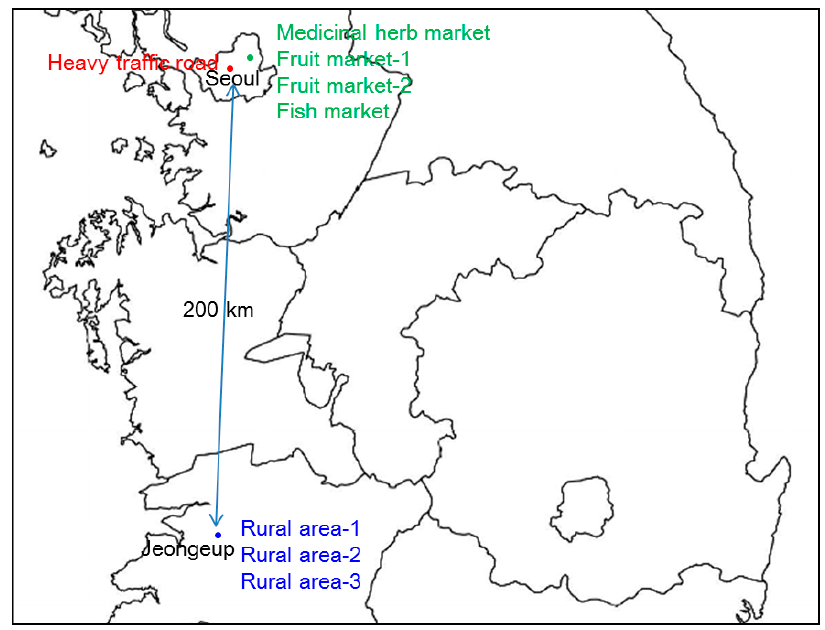
Figure 1. Sampling locations: a medicinal herb market, a fish market, two fruit markets, and a heavy traffic area in Seoul, and rural areas in Jeongeup, South Korea.